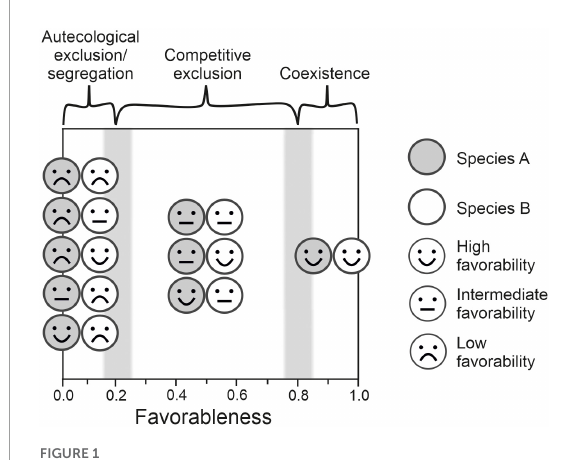
FIGURE1 Expected biogegraphical outcomes